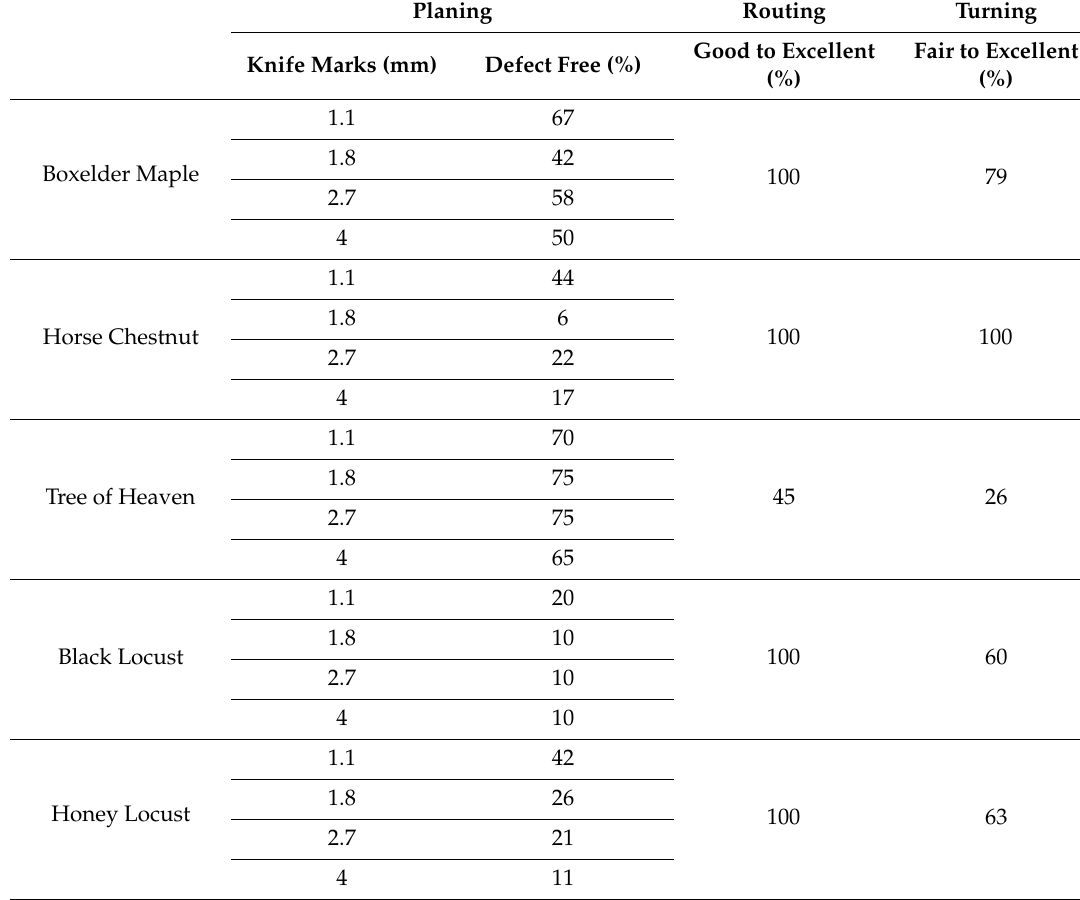
Table 7. Base comparison of the surface quality grades for di ff erent machining operations and tree